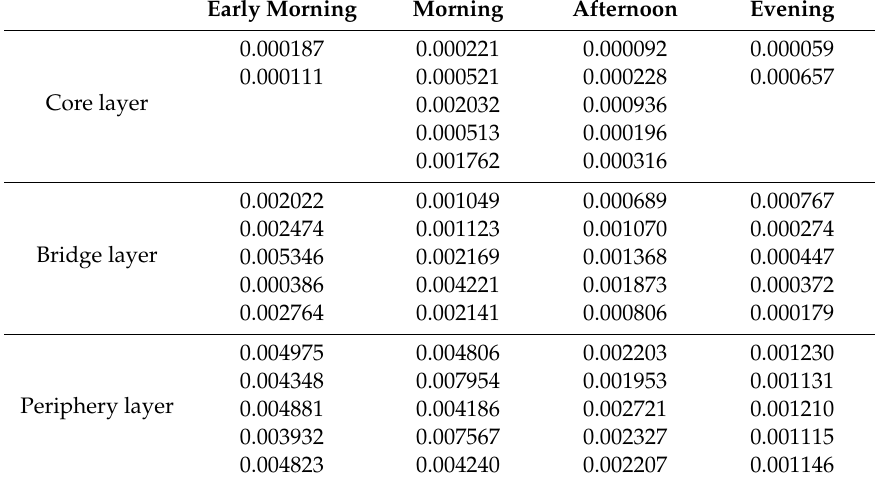
Table 4. Top five places with the largest coreness values in the core layer, the bridge layer, and the periphery layer on weekdays. Value is the cluster coe ffi cient of a place.